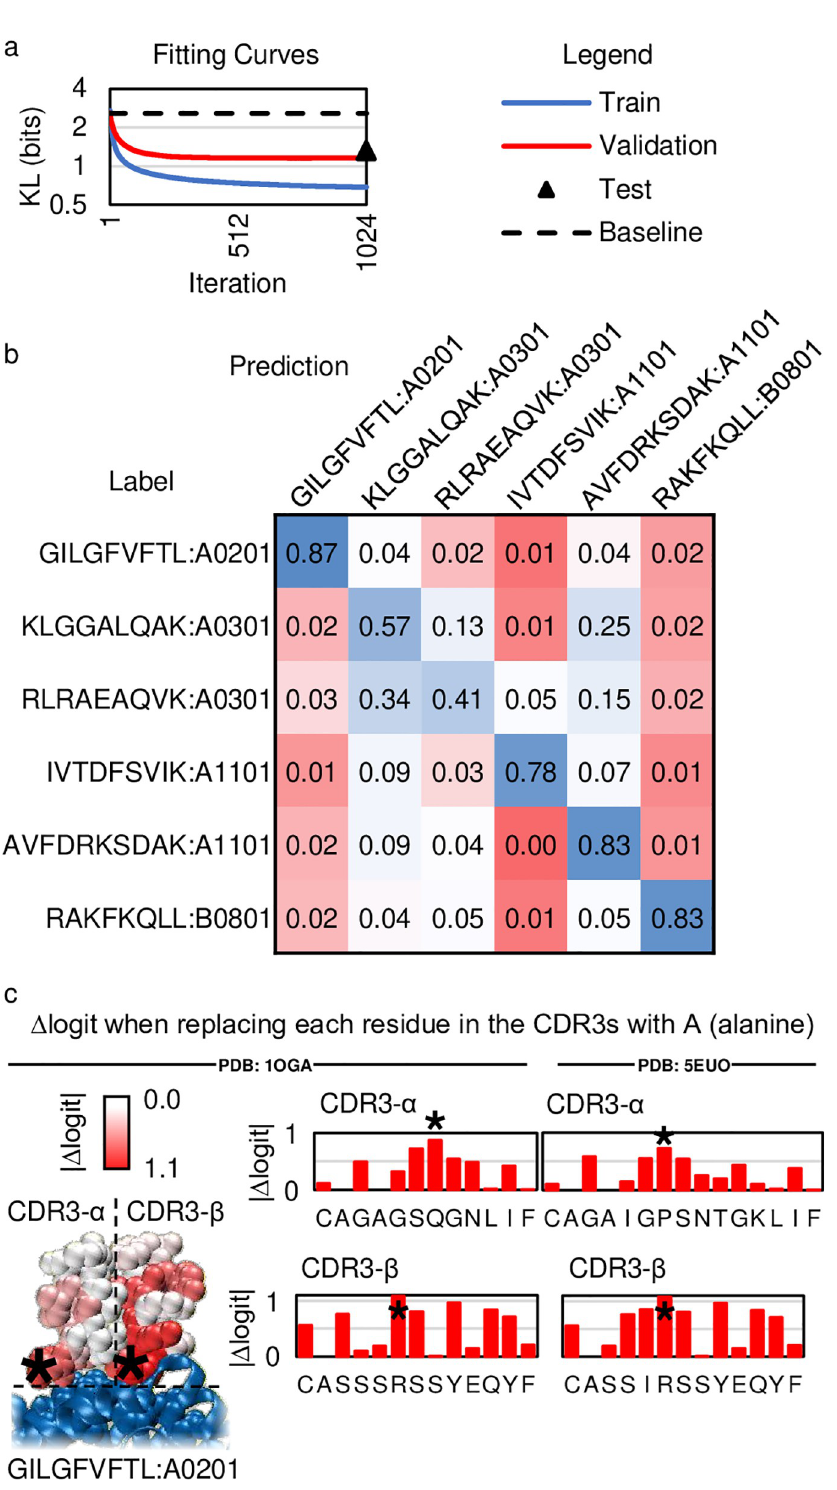
Fig 2. Results on the antigen classification problem. (a) The fit plotted for each weight update across the training (solid blue) and validation cohorts (solid red) steadily improves with each gradient optimization step. The fit to the test cohort after unblinding the samples (triangle) is significantly better than the baseline performance achievable by random chance (dashed black). (b) A confusion matrix of samples from the test cohort reveals the fraction of predictions that agree with the labels for each category (c) A 3D X-ray crystallographic structure of a TCR bound to GILGFVFTL:A0201. An alanine scan of the TCR CDR3 sequences reveals the largest | Δ logit| always corresponds to a contact position